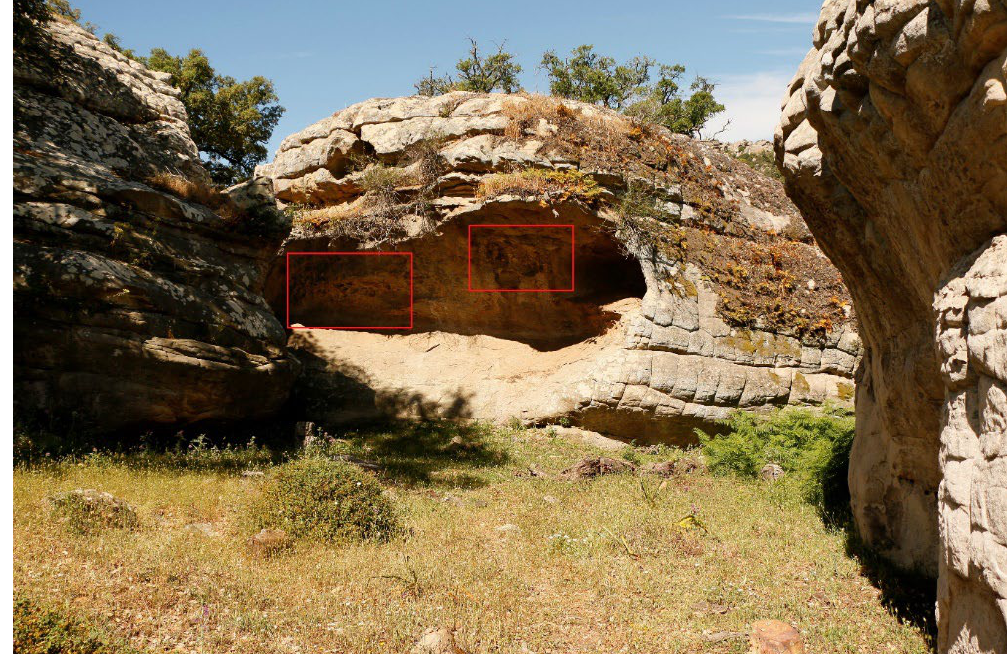
Figure 4. General views of Bacinete III. The location of the rock art panels is framed in red. Photograph by N. Santos da Rosa, Artsoundscapes Project, 2021.